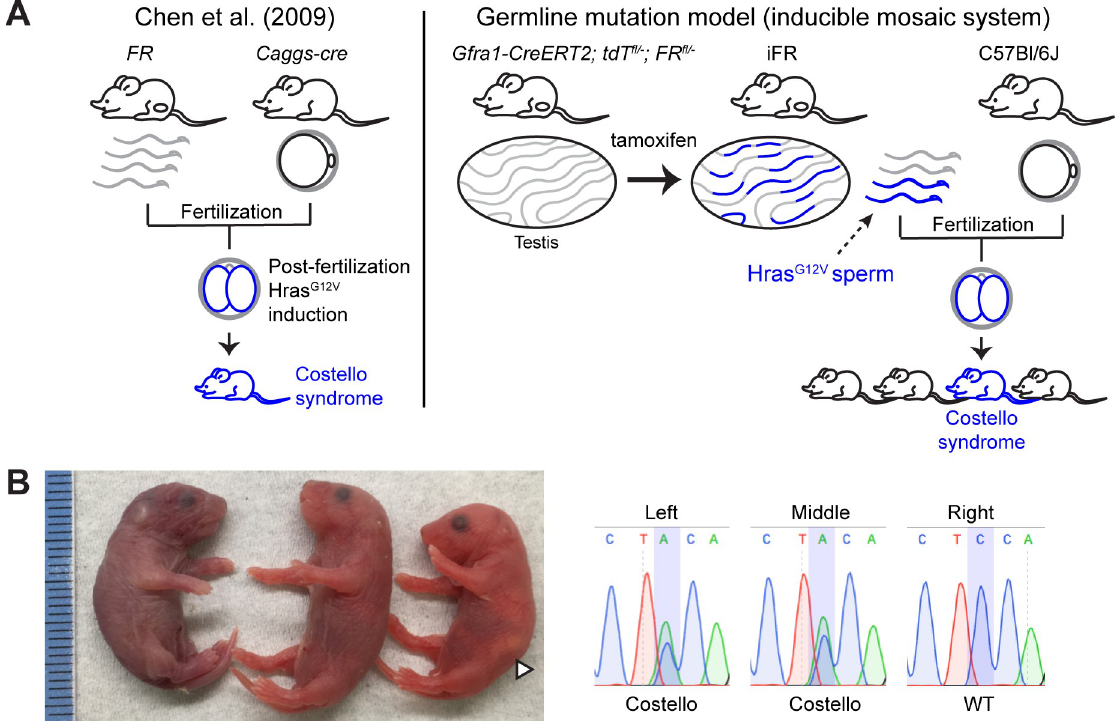
Fig 3. Generation of offspring with Costello syndrome. A. Germline mutation models. The previous model (left) generated by Chen et al. (2009) induces Hras G12V after fertilization. The mosaic germline mutation model (right) induces mutations in a fraction of the undifferentiated spermatogonia and enables functional studies of mutant cells among wild-type neighbors and the propagation of the mutation induced in the stem cells to subsequent generations. B. Postnatal day 0 pups born from iFR (male) x C57 (female). Genotyping using RNA revealed that the left two were Costello ( Hras G12V ) offspring and the right was wild-type, whose corresponding Sanger sequencing results are shown on the right. The left pup was found dead. The middle one was cyanotic and did not have a milk spot, whereas the right wild-type was pink and showing a milk spot (white arrow